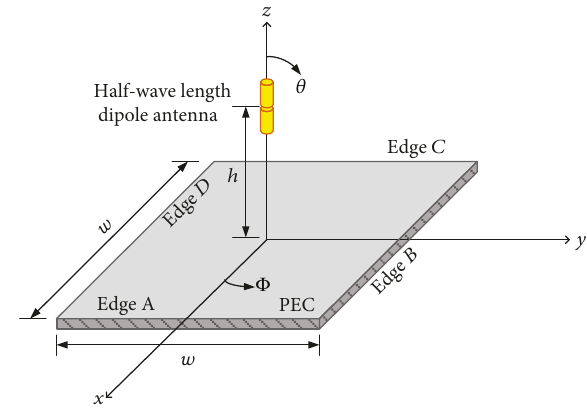
Figure 2: PEC square patch excited by a half-wavelength dipole antenna.